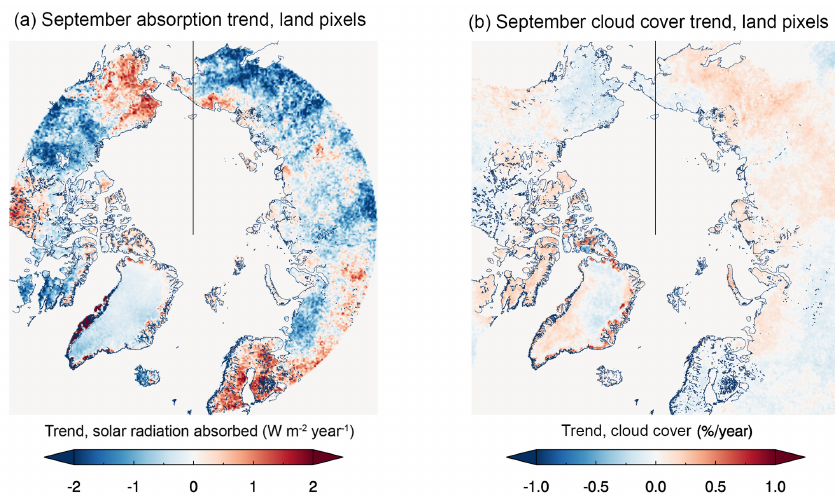
Figure 3. Trends in absorbed shortwave radiation over land (a) and cloud cover trends over land (b) during September.